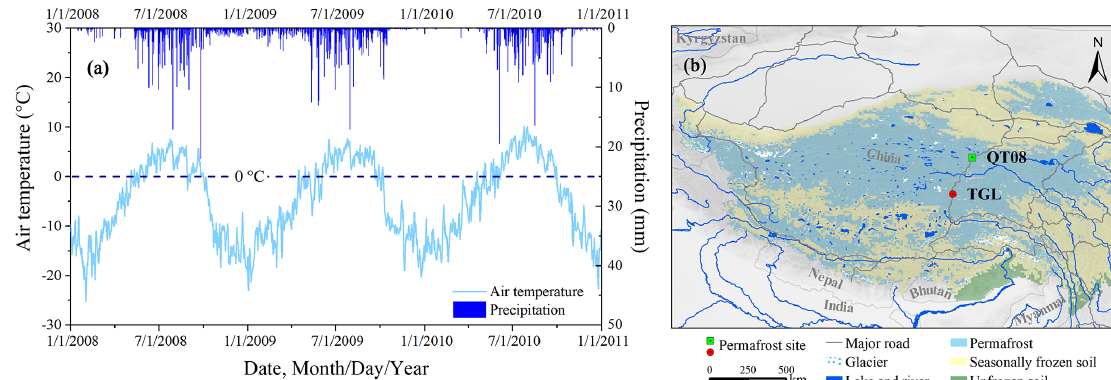
Figure 1. Air temperature and precipitation (a) at the Tanggula (TGL) site during 2008–2010 and the map (b) showing the locations of permafrost sites considered in this study. Time series of daily air temperature at 2m height and precipitation at TGL aggregated from the hourly measurements. The base map of permafrost distribution on the Qinghai–Tibet plateau (QTP) is from Zou et al.